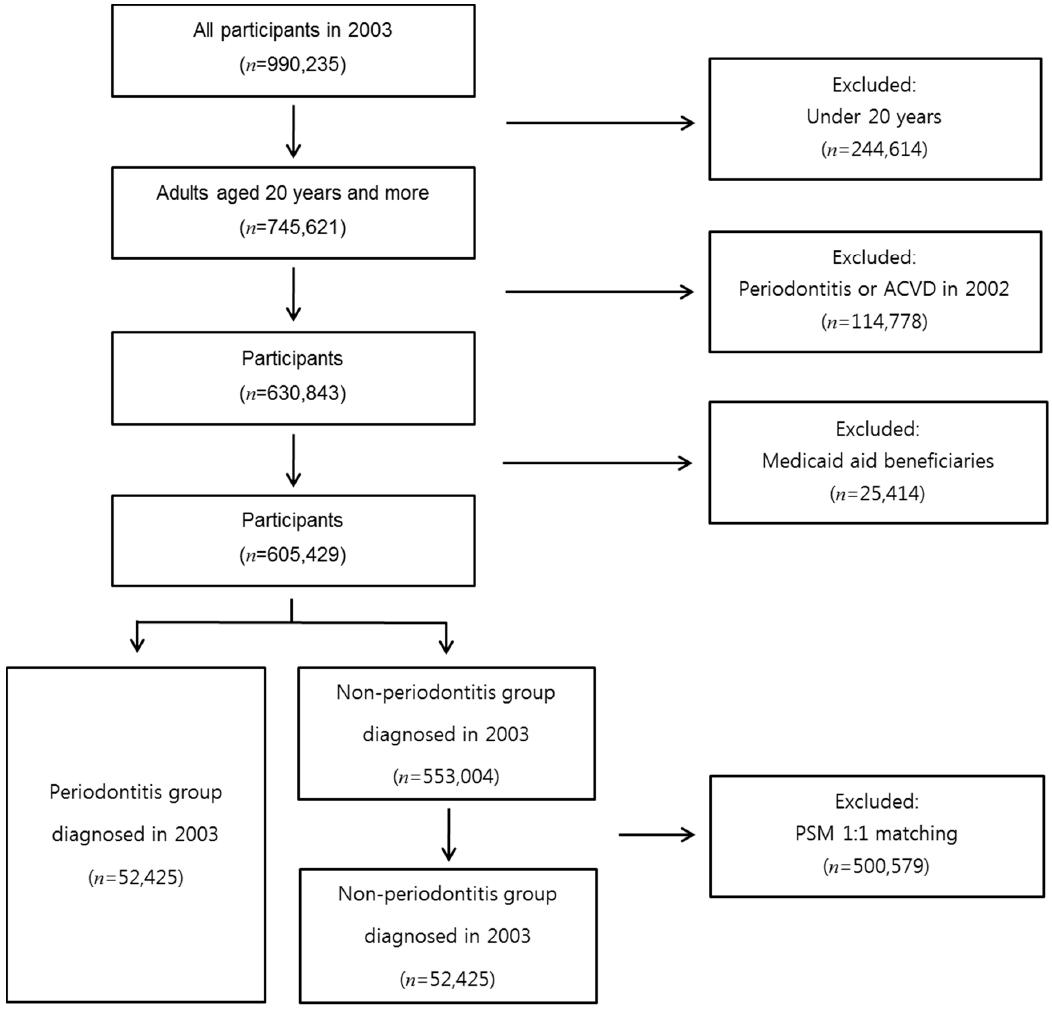
Figure 1. Study population selection process from the NHIS-NSC2 database. ACVD: atherosclerotic cardiovascular disease. PSM: propensity score matching. NHIS-NSC2 database: National Health Insurance Service—National Sample Cohort 2.0 database.